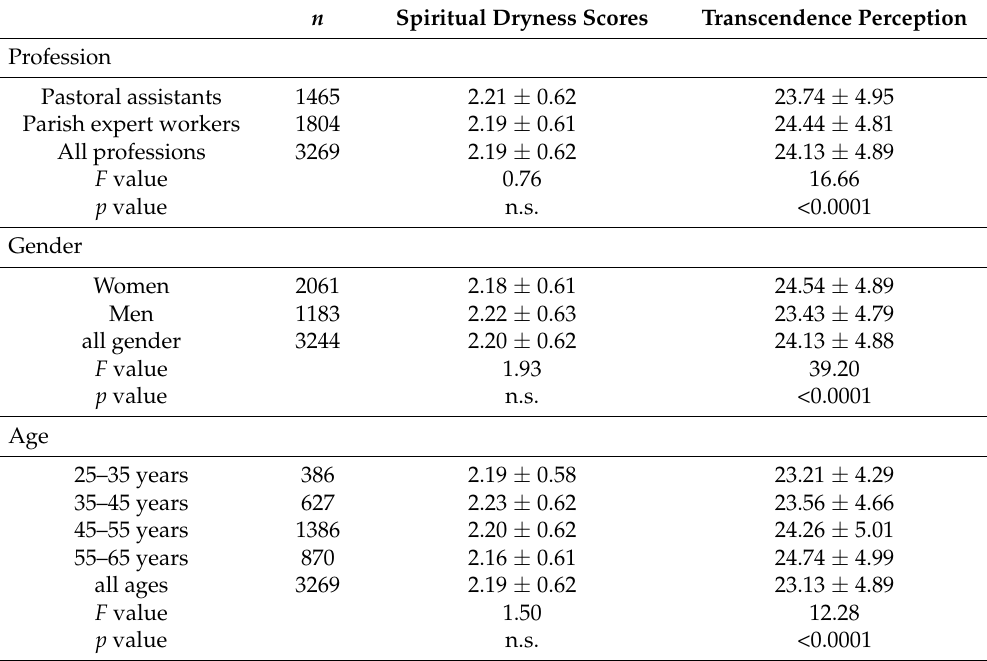
Table 1. Mean scores of Spiritual Dryness Scale (SDS) within the sample. n Spiritual Dryness